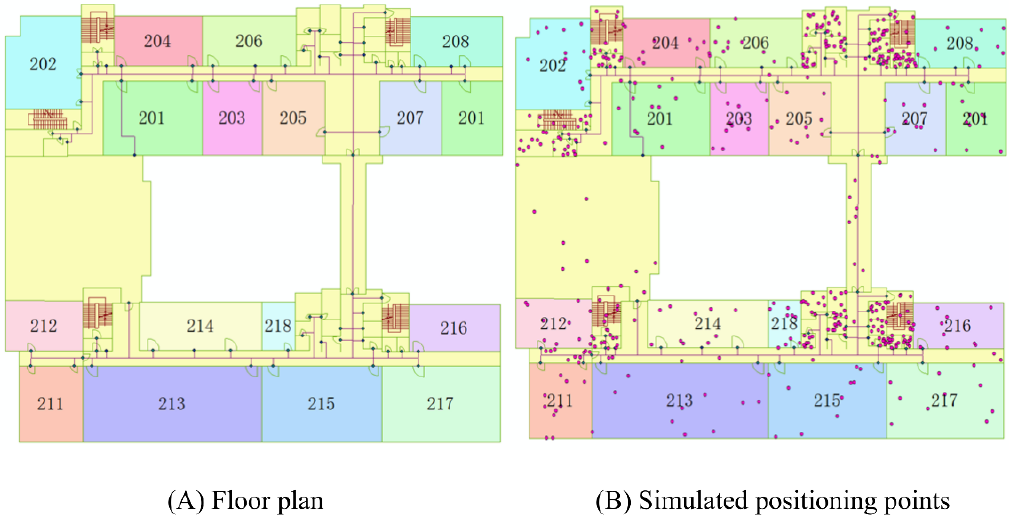
Figure 16. ( A,B ) Simulated floor plan and the positioning points.